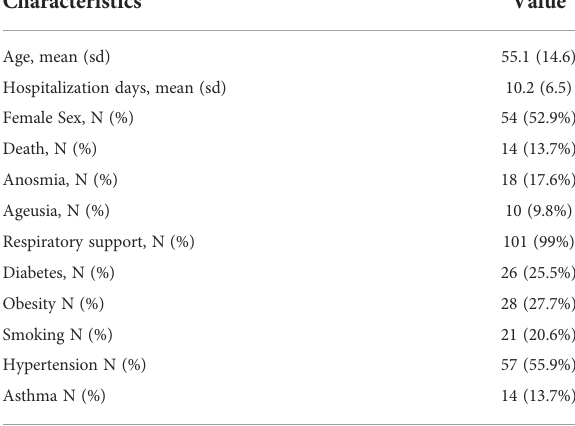
TABLE 1 Demographic and clinical characteristics of the study sample (n = 102).